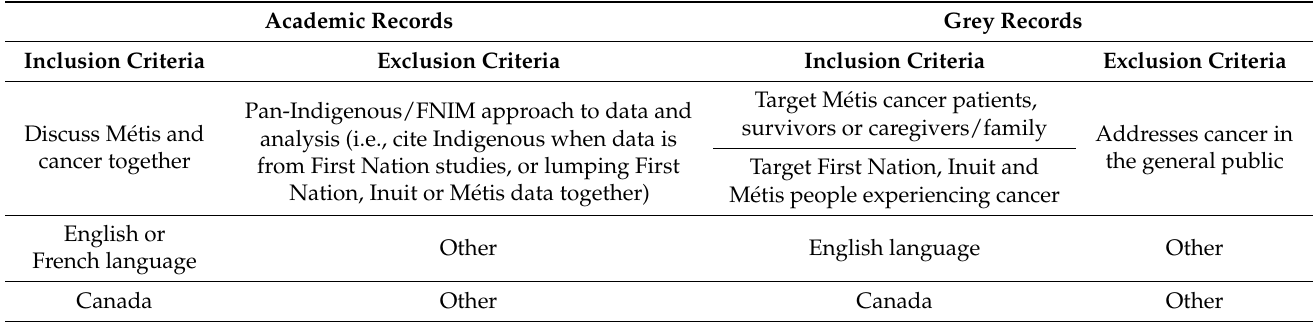
Table 3. Inclusion/exclusion